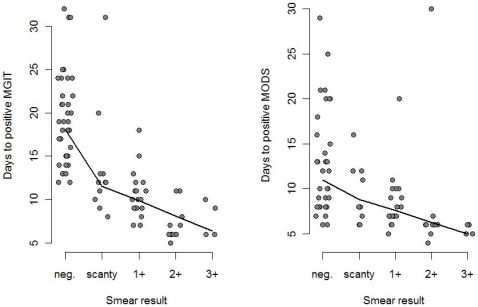
Time to MGIT positive and MODS positive in relation to smear grade.Filled dots are samples positive by either MGIT or MODS, lines are scatter plot smoothers. Both MGIT and MODS had a negative Spearman rank correlation with smear grade (P<0.001).